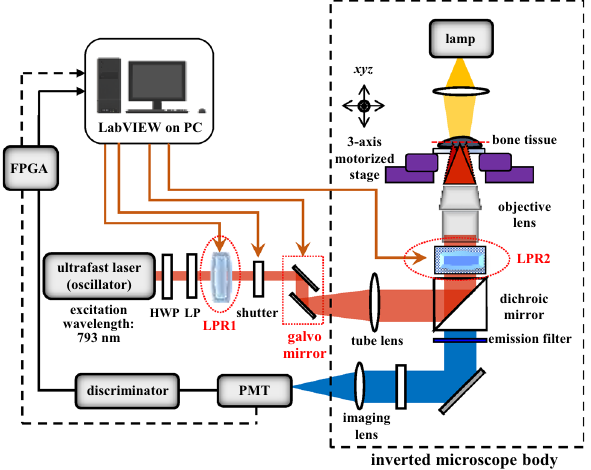
Figure 7. Schematic representation of dual-liquid–crystal-based P-SHG microscope. LPR1 and LPR2 denote first and second liquid crystal polarization rotators,